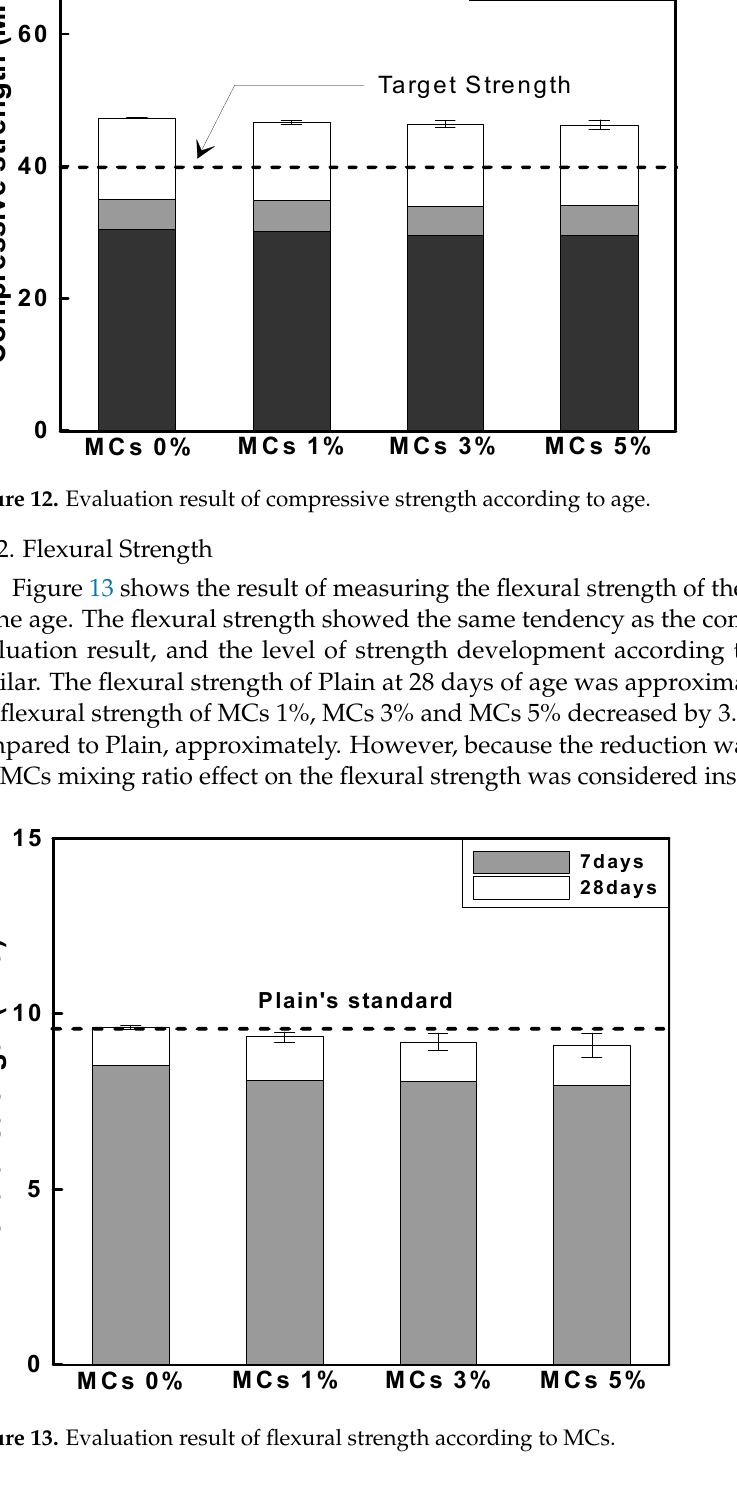
Figure 13. Evaluation result of flexural strength according to MCs.